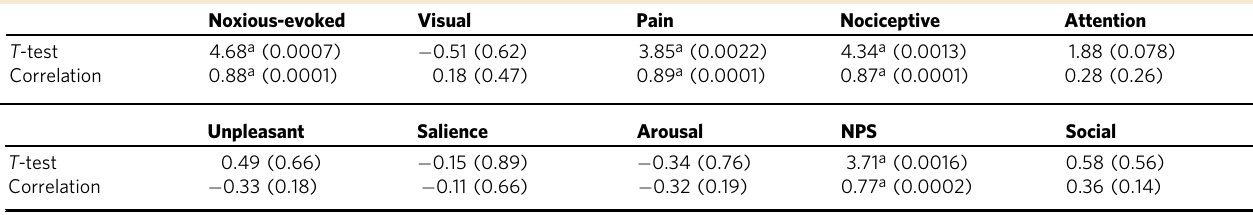
Table 1 Noxious-evoked responses are pain-relevant signals.